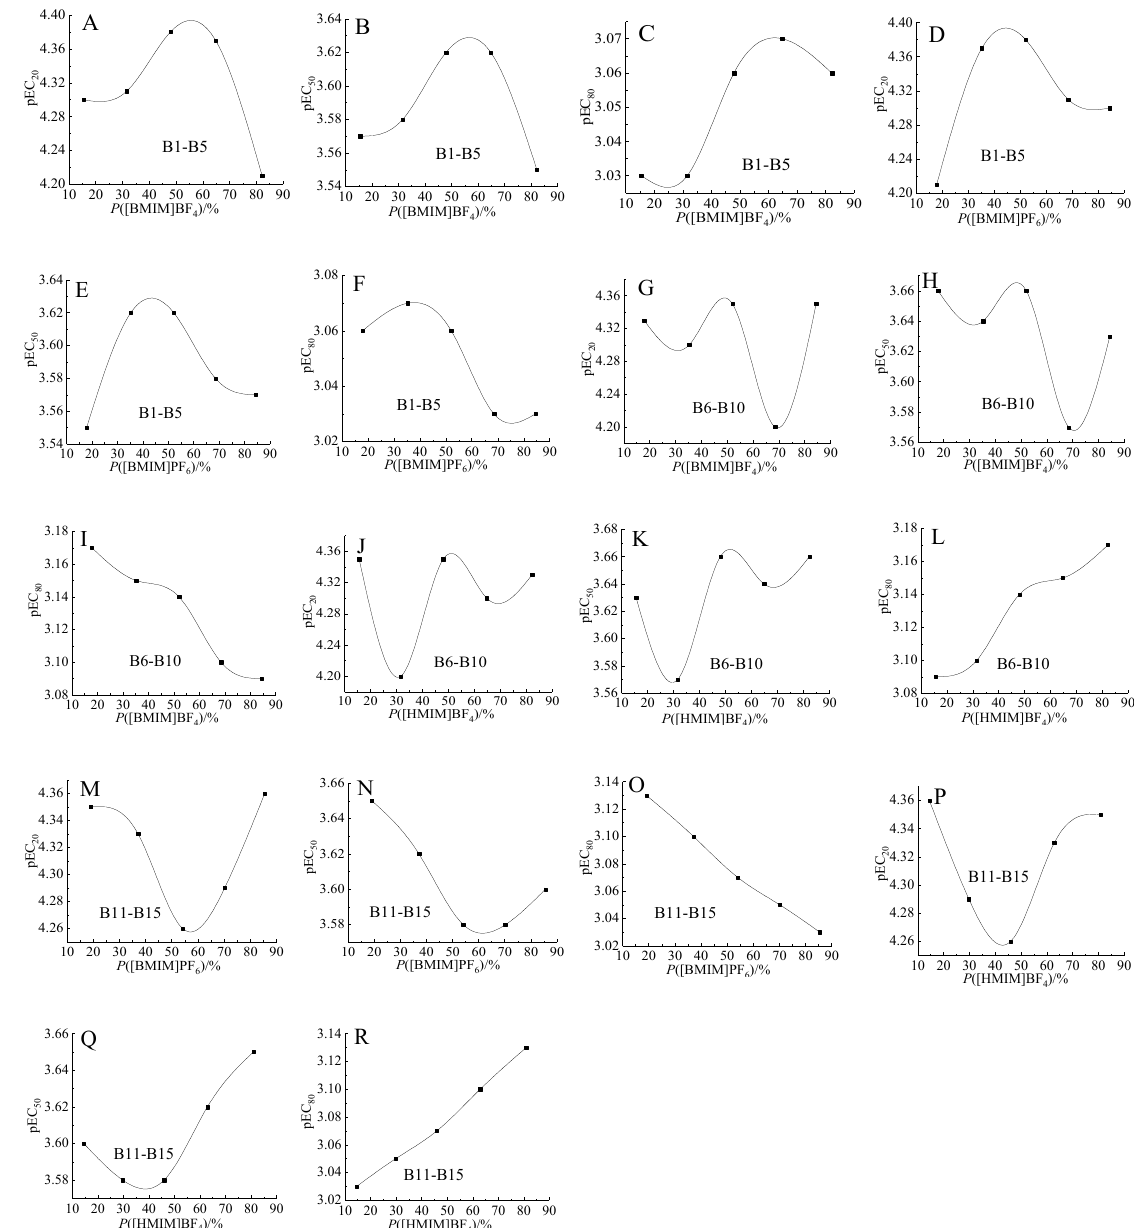
Figure 3. Relationship between the toxicity (pEC x ) of binary mixtures and the concentration proportion of components. ( A – F ): mixtures of [BMIM]BF 4 and [BMIM]PF 6 ; ( G – L ): mixtures of [BMIM]BF 4 and [HMIM]BF 4 ; ( M – R ): mixtures of [BMIM]PF 6 and [HMIM]BF 4